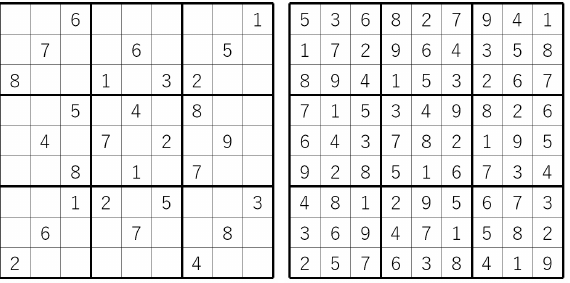
Figure 1. Sudoku clues ( left ) and its solution ( right